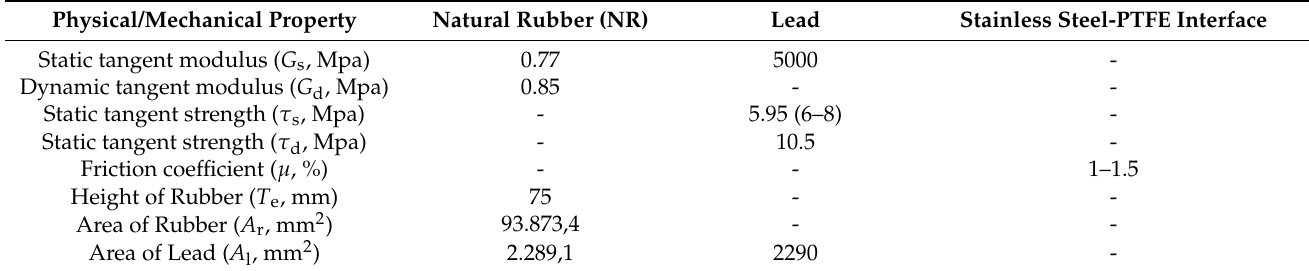
Table 3. Physical and mechanical properties of LRB (rubber only), lead, and stainless steel-PolyTetraFluoroEthylene (PTFE) interface.